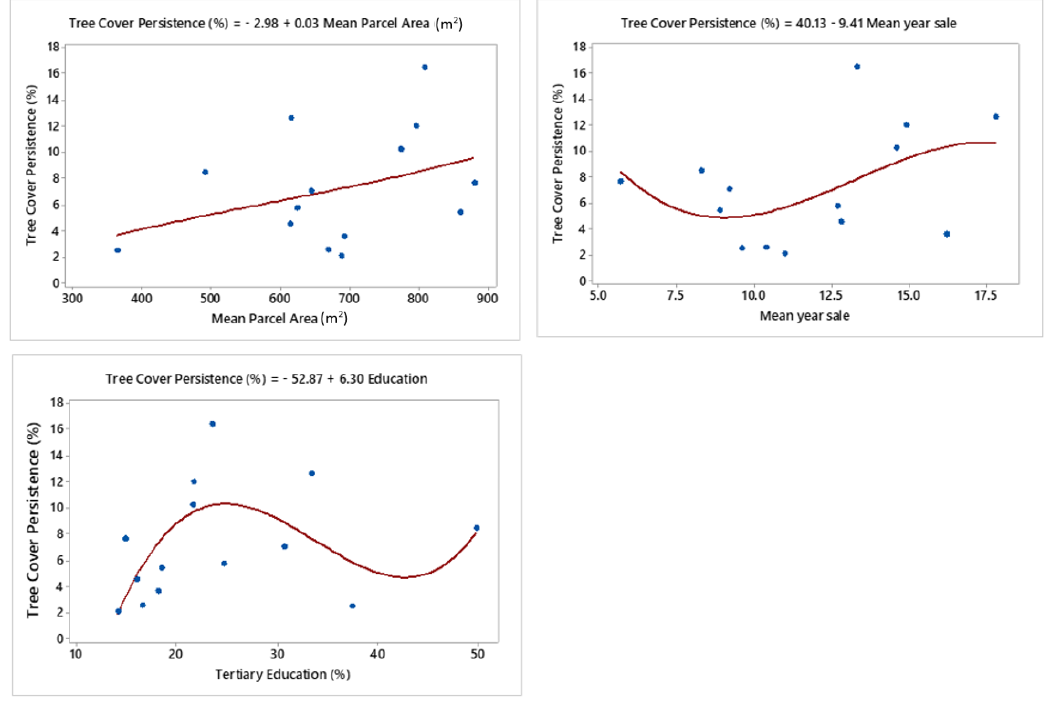
Figure 15. Sample level tree cover persistence versus mean parcel area (m 2 ), mean number of years between the most recent sale in the period 2000–2015 and 2015 and tertiary education